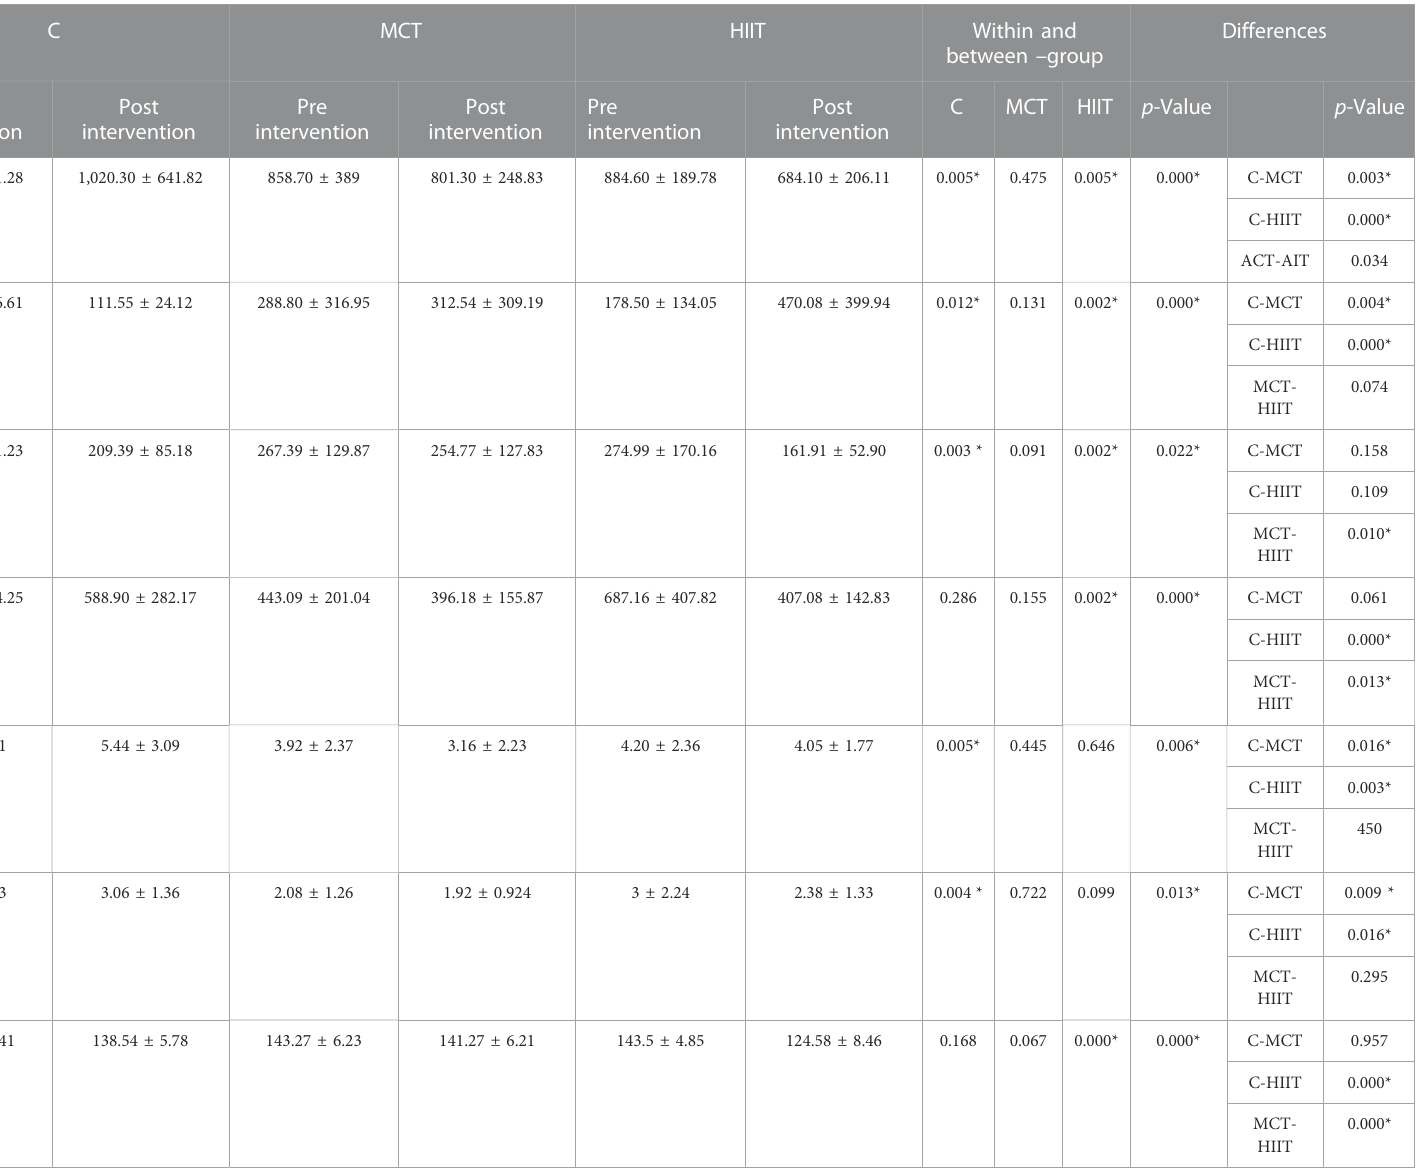
TABLE 4 Within and between-group differences, analyzed by Wilcoxon, Kruskal-Wallis, and Mann-Whitney U tests.